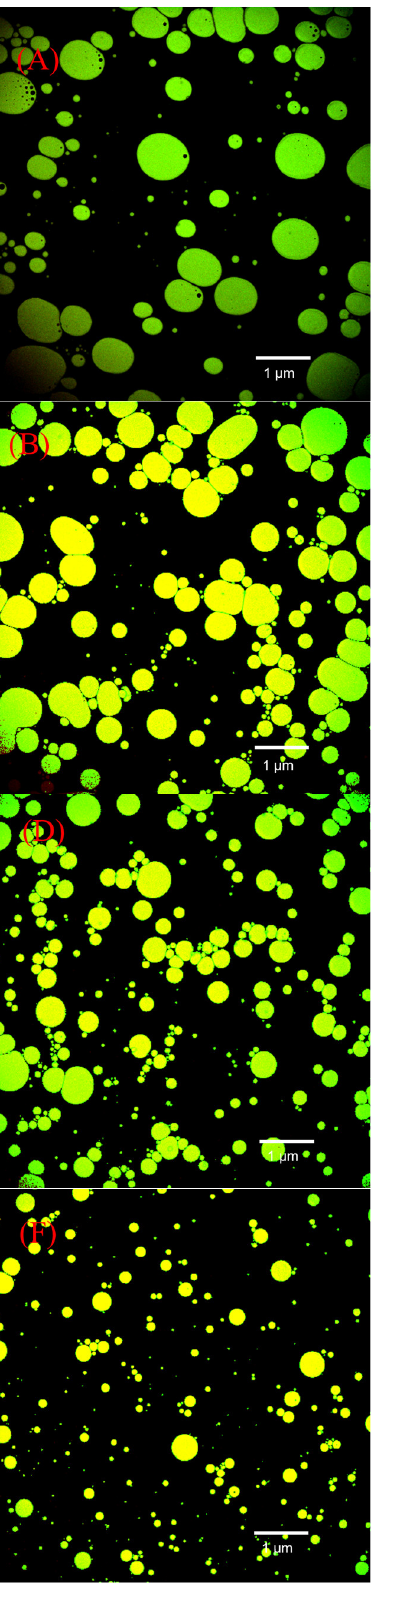
Figure 13. Representative CLSM images of emulsions created with the samples. ( A ) The SPI; ( B ) the mixture of SPI and GOS; ( C ) the traditional wet heating Maillard reaction group; ( D – G ) the HPH treatment groups.